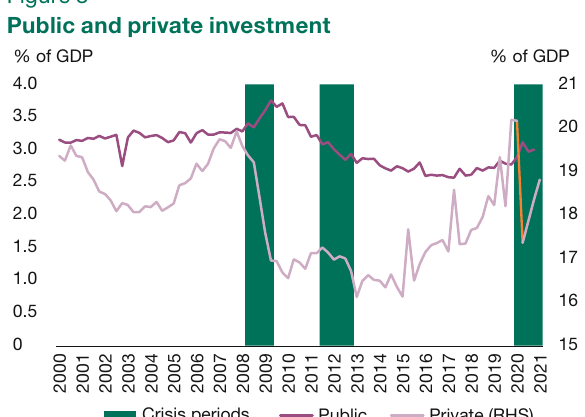
Public and private